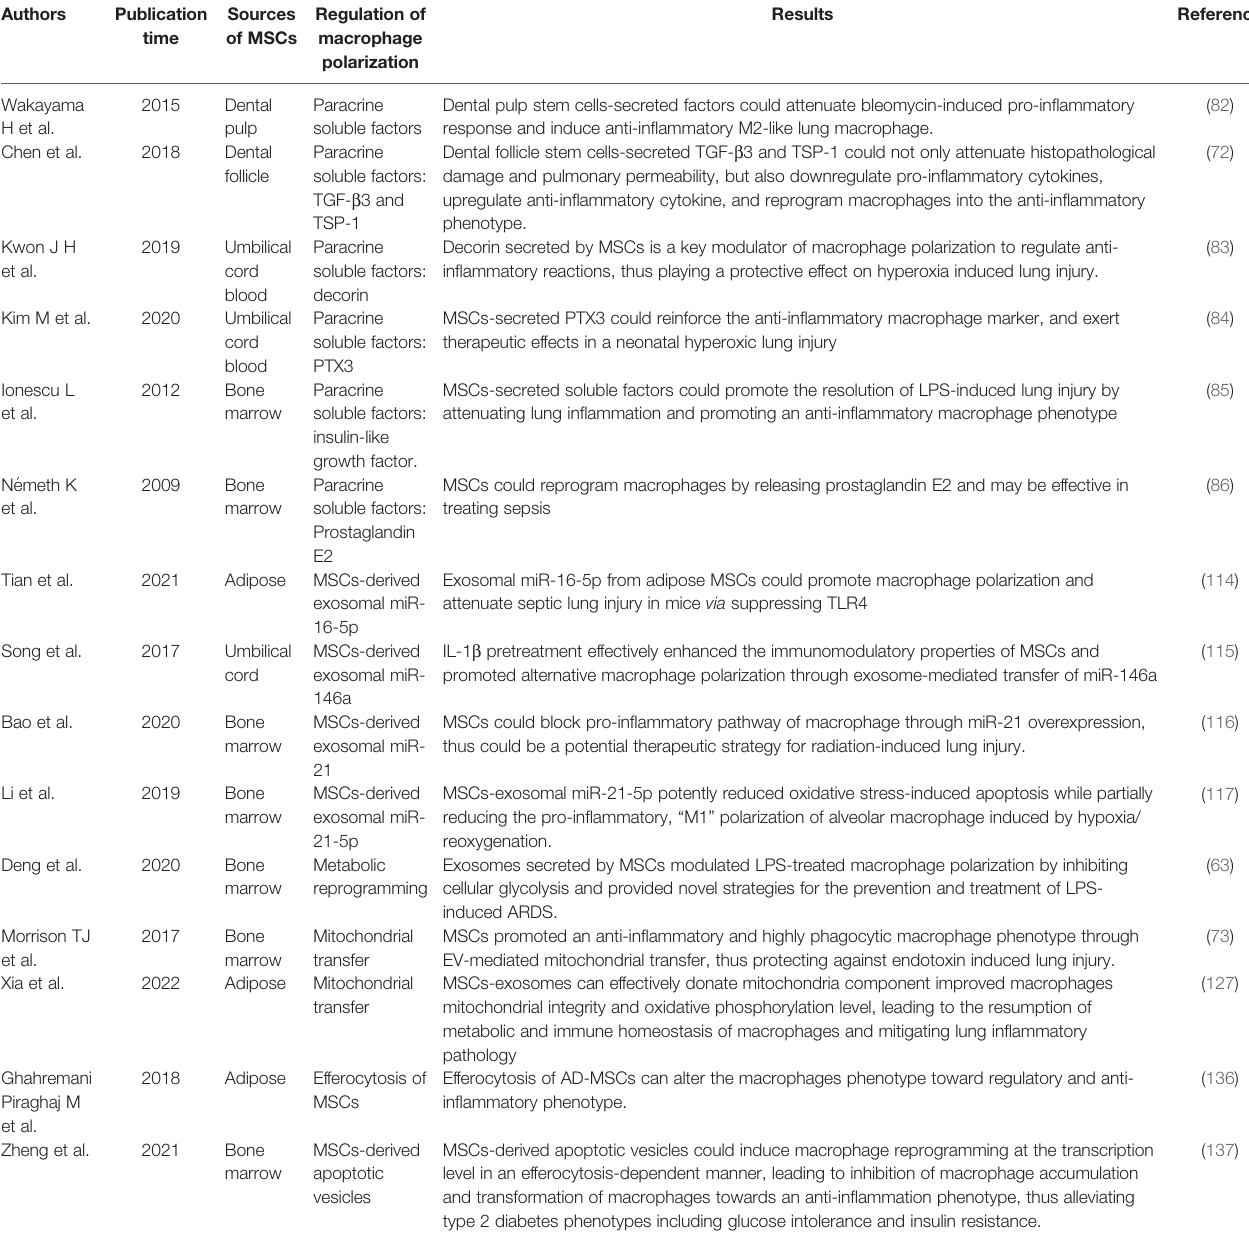
TABLE 1 | The ways MSCs regulate macrophage